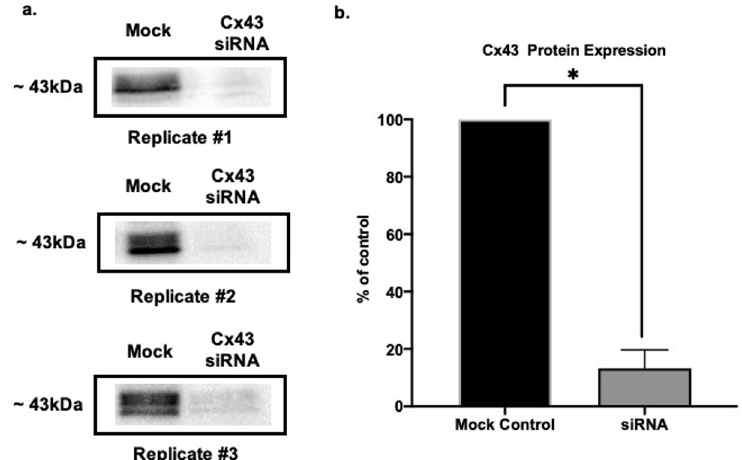
Figure 1. Validation of knockdown of Cx43 expression in astrocytes by siRNA. By using Western blot, levels of Cx43 protein were determined in mock-transfected (transfection reagent with no siRNA) and Cx43 siRNA-transfected astrocytes. Although the data are not shown for each experiment, this validation was performed for each biological replicate of the b-SPM experiments and Cx43 was consistently knocked down. ( a ) Representative Western blot membranes showing knockdown of Cx43 protein expression in primary cultured cortical astrocytes 72 h after transfection with Cx43 siRNA. Cx43 was detected as two bands (phosphorylated and un-phosphorylated) at approximately 43 kDa, and both were used for the calculations shown in the summary. The representative blots show samples from the three biological replicates for the experiment in Figure 2. ( b ) Summary of Cx43 protein expression in mock- and siRNA-transfected astrocytes. Data are expressed relative to mock, which was taken as 100%. The asterisk indicates a significant difference from mock ( t -test; p < 0.05; n = 3 for both groups). India ink was used for total protein to discern small differences in protein loading (stained membrane is not